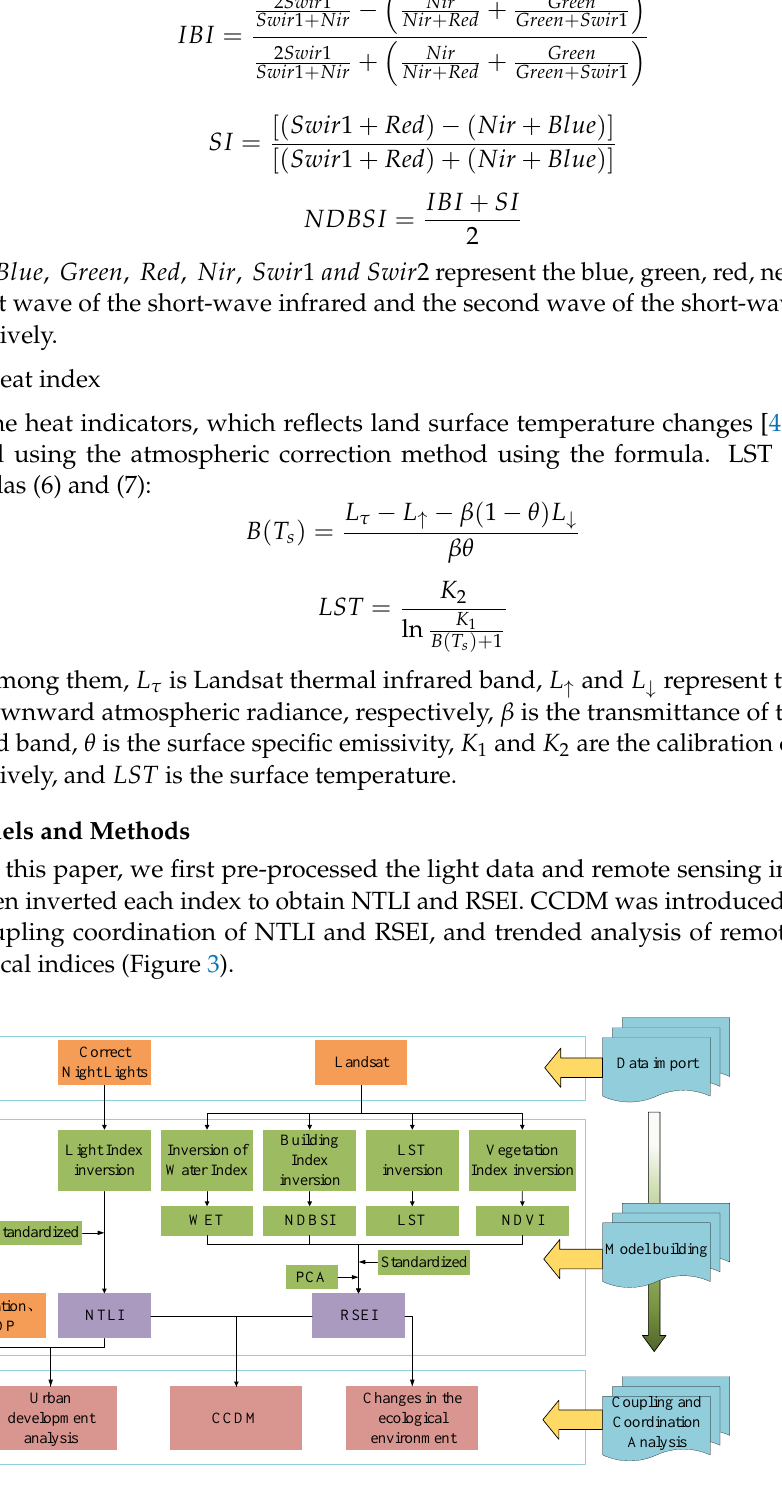
Figure 3. The technology roadmap for this